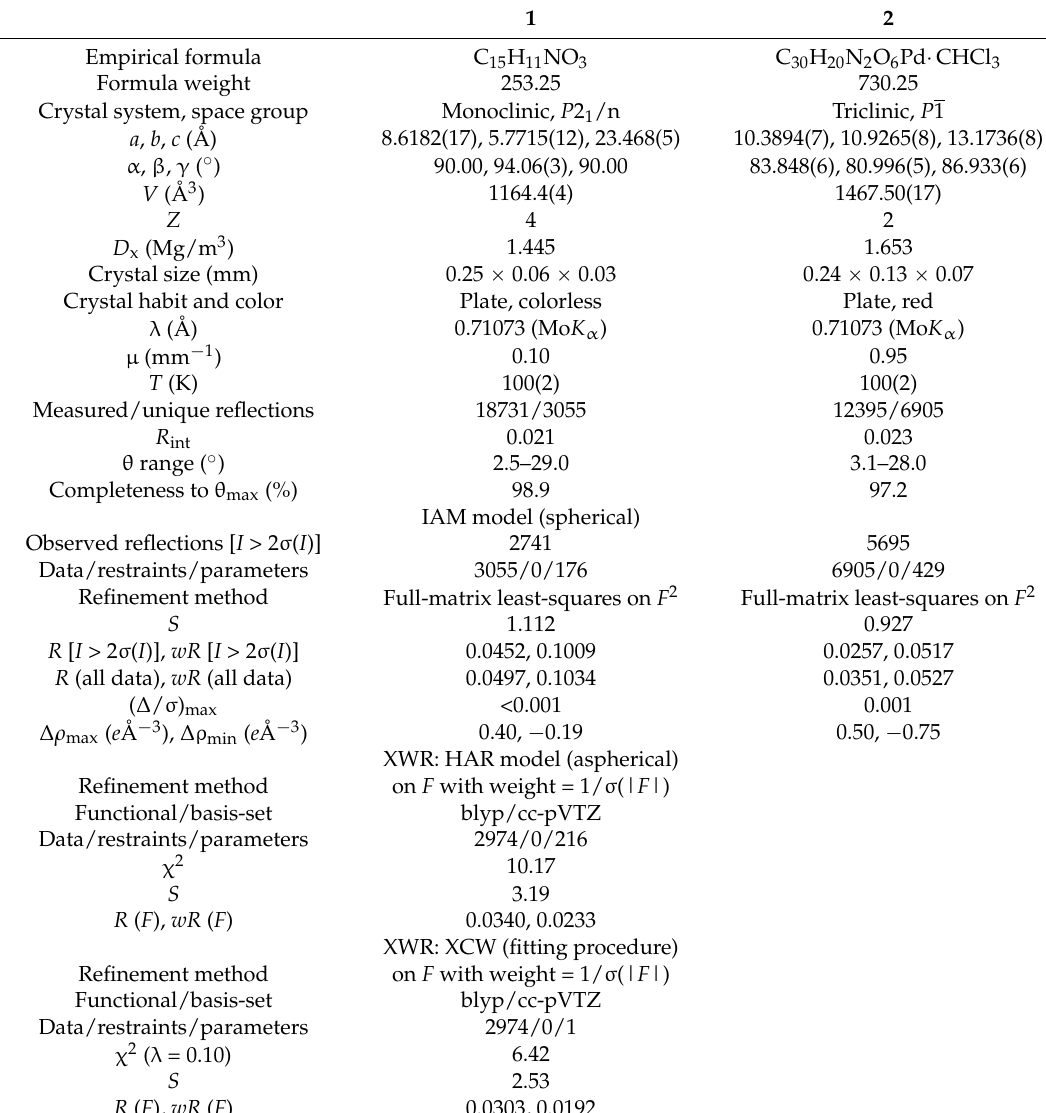
Table 1. Crystallographic data of 1 and